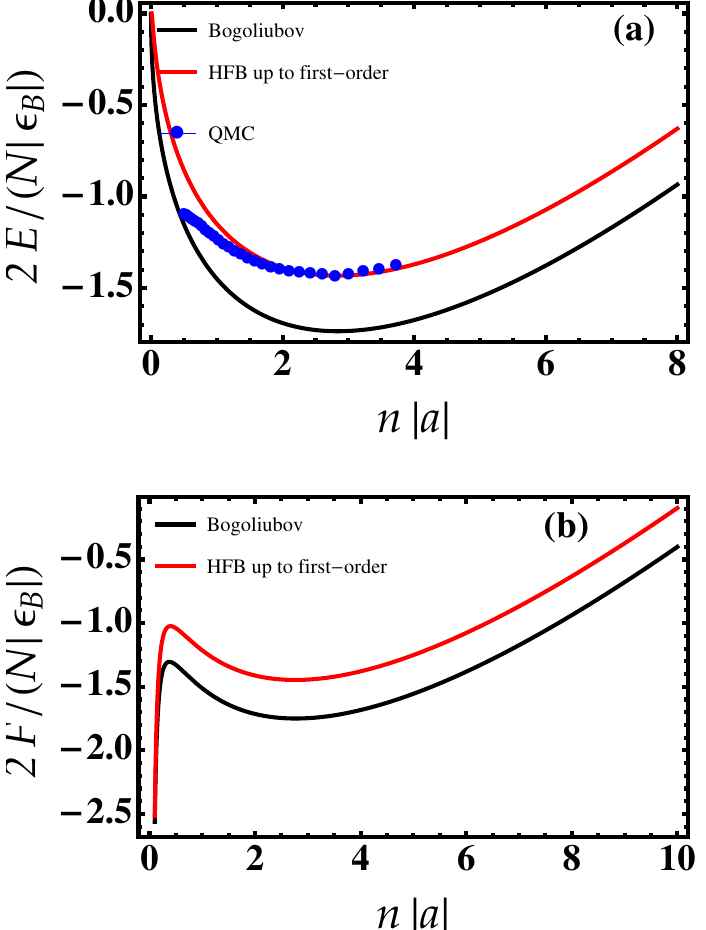
Figure 6. (Color online) ( a ) One-dimensional ground-state energy as a function of the density for g 12 / g = − 0.7. ( b ) One-dimensional free energy as a function of the density for g 12 / g = − 0.7 and T / ε B = 0.15. Here, the energies are normalized by the binding energy of dimmers composed from ) atoms from different components ε B = − ¯ h 2 / ( ma 2 12